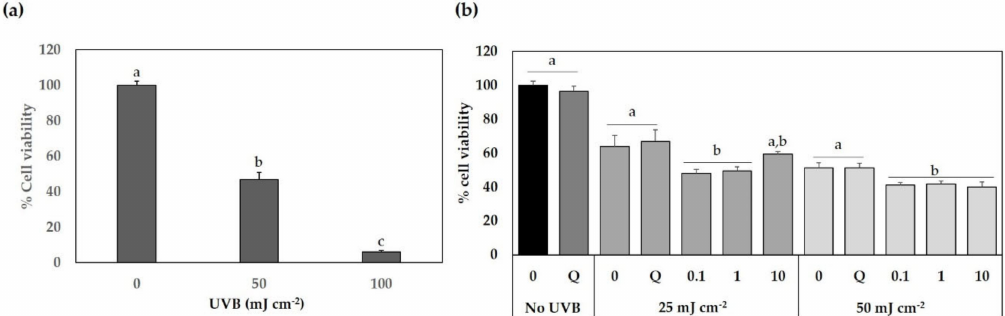
Figure 7. E ff ects of the optimized supercritical fluid (SFE) extracts derived from Naxos broccoli by-products (SFE-NX) on the viability of HaCaT keratinocytes exposed to ultraviolet B (UVB) light. In ( a ) HaCaT cells were irradiated with specific doses of UVB light (50 and 100 mJ cm − 2 ) and cell viability was determined using an MTT assay after 24 h. In ( b ) HaCaT cells were pre-treated with di ff erent concentrations of SFE-NX extract (0.1, 1 and 10 µ g extract mL − 1 ), exposed to UVB light (25 and 50 mJ cm − 2 ) and cell viability was measured after 24 h. Q: quercetin (30 µ g mL − 1 , positive control). Cell viability is expressed as a percentage of the control. Di ff erent letters (a–c) denote